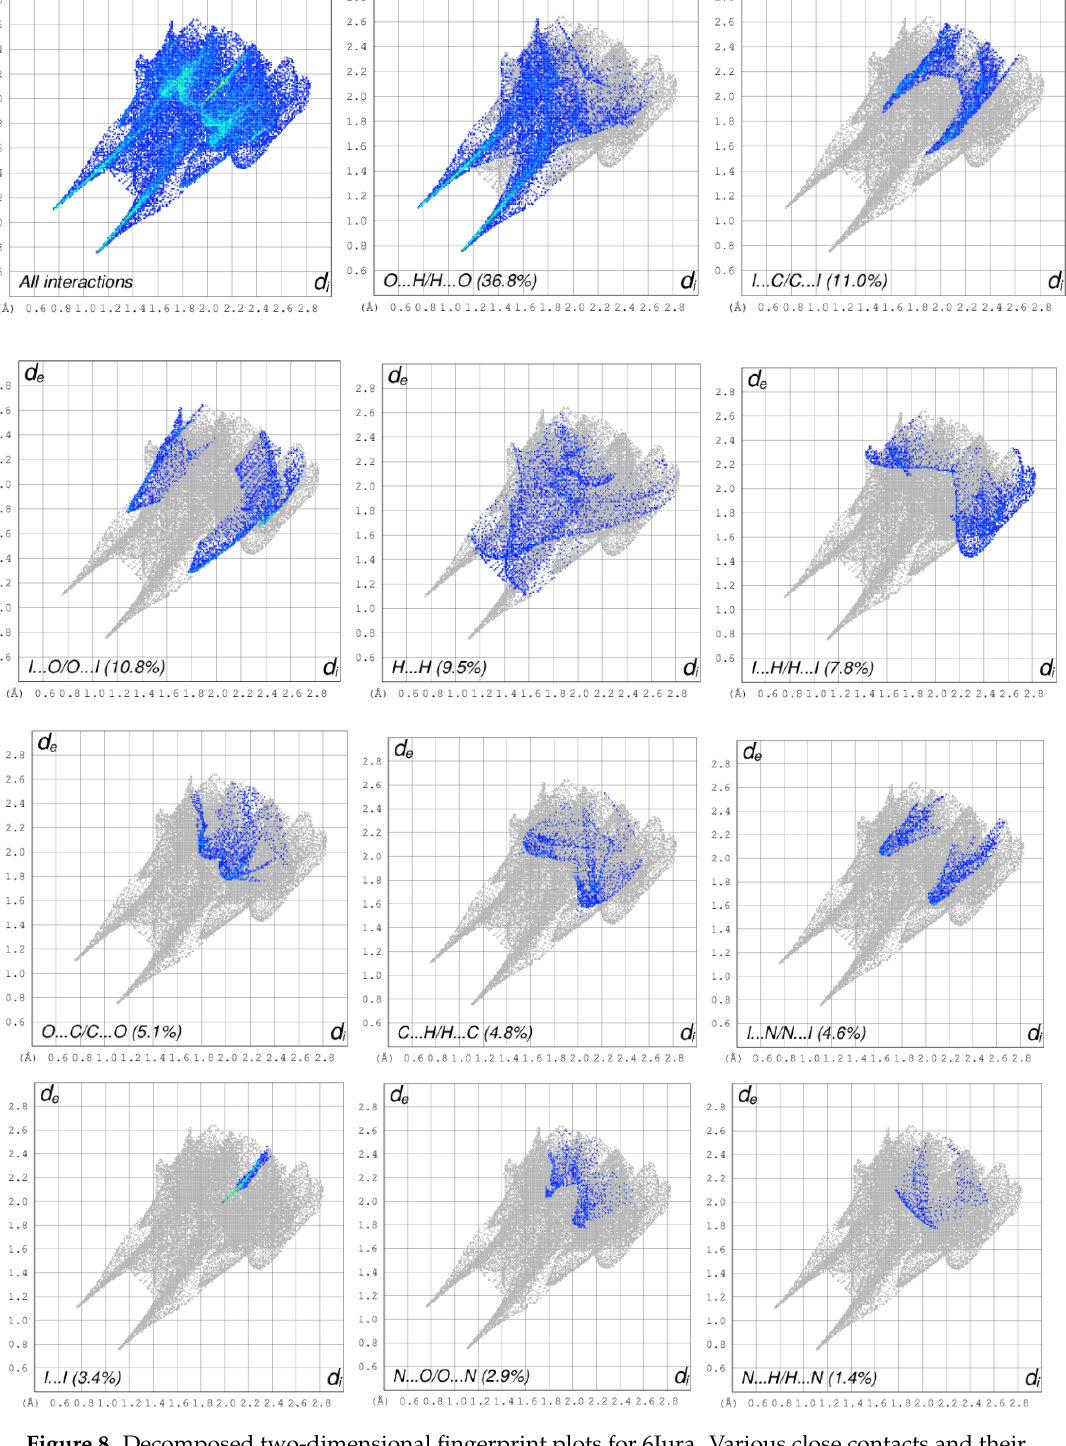
Figure 8. Decomposed two-dimensional fingerprint plots for 6Iura. Various close contacts and their proportional contributions are reported. Other (not shown) intermolecular contacts contribute less than 2% to the Hirshfeld surface mapping. Table 6. Contributions of the intermolecular contacts for compounds 5 and 7.